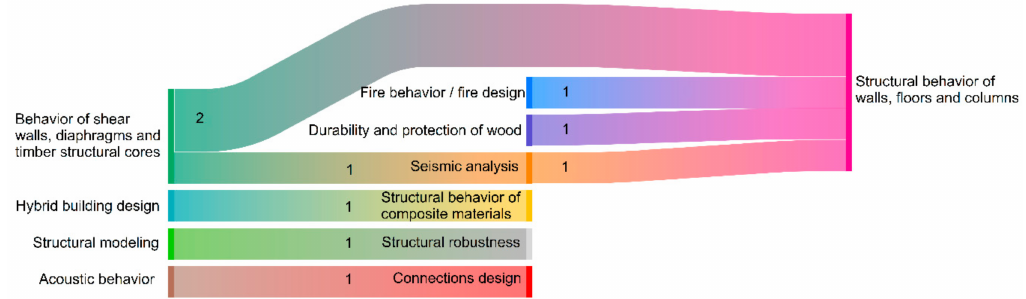
Figure 7. Relationships between the findings considered limitations of the engineering and construc- tion sciences category, based on the review of scientific articles on multi-storey timber